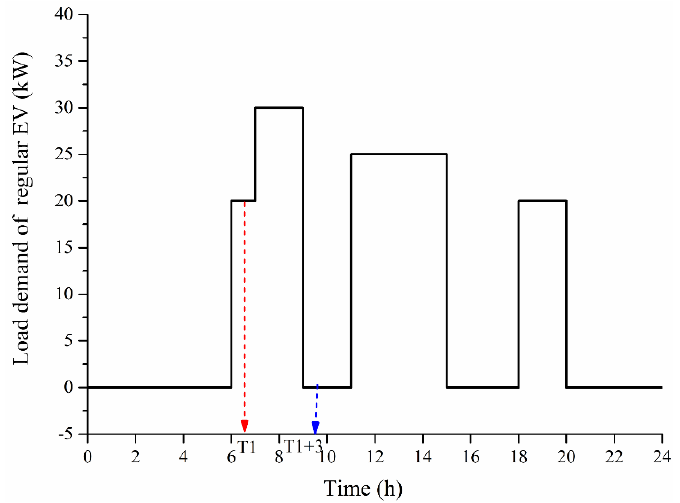
Figure 2. Daily load curve of regular